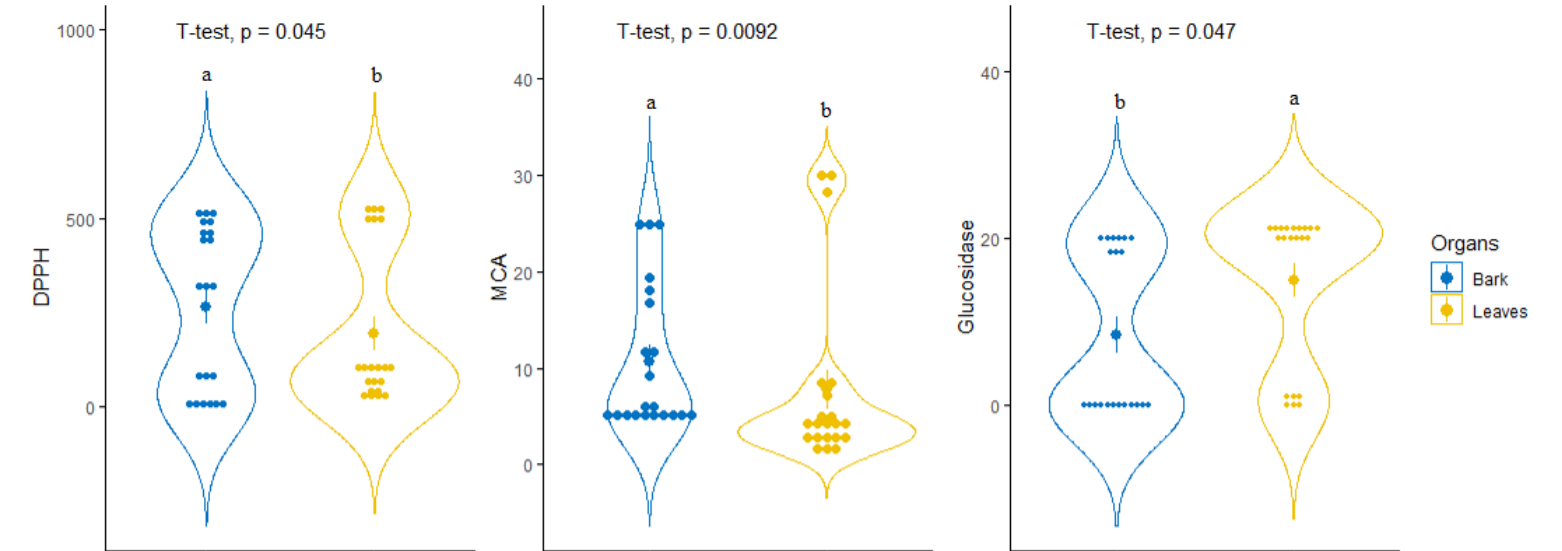
Figure 4. Comparison of leaves and bark taking account of the identified most discriminant biological activities.